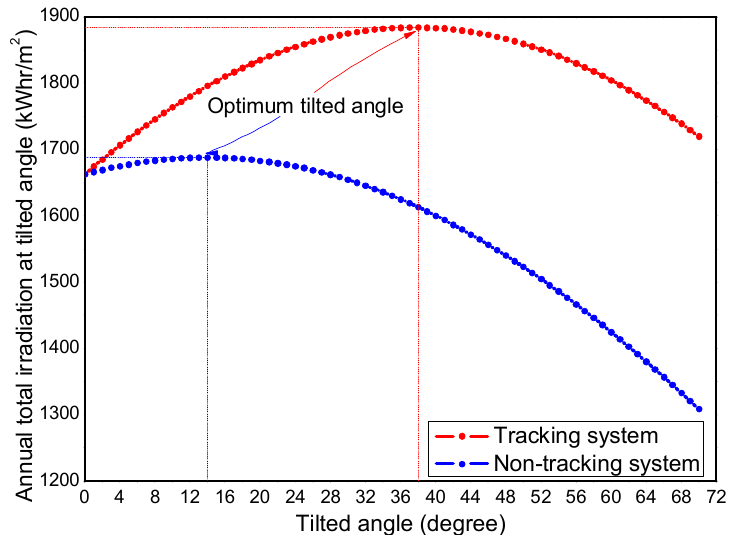
Table 4. Analysed numbers of days in every month of a year for different weather conditions.